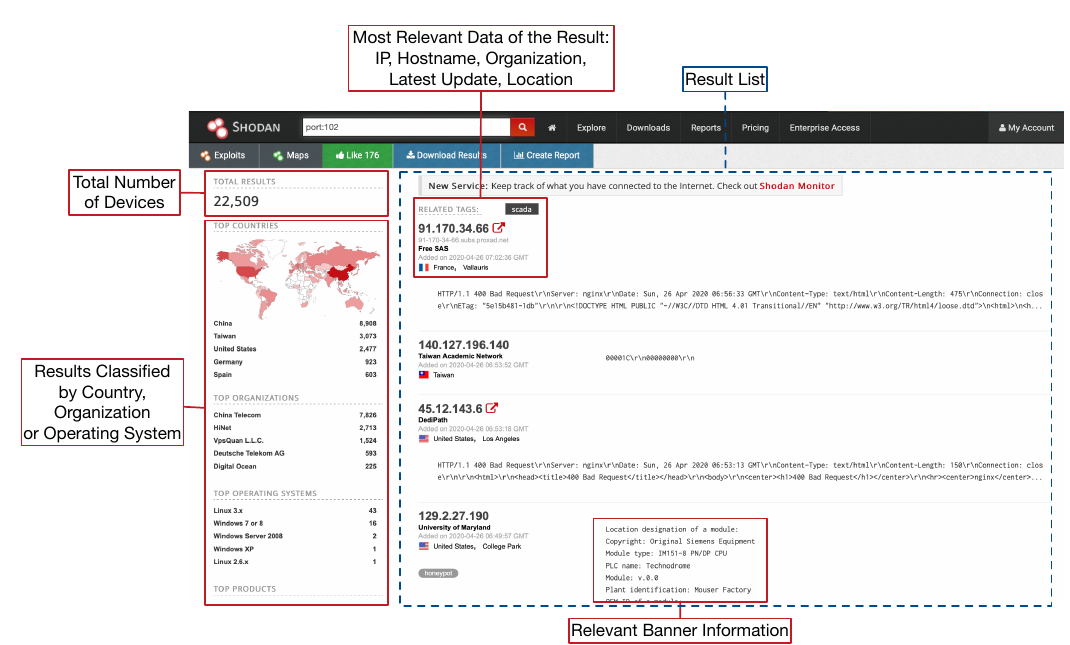
Figure 2. Shodan result list of potential Siemens S7